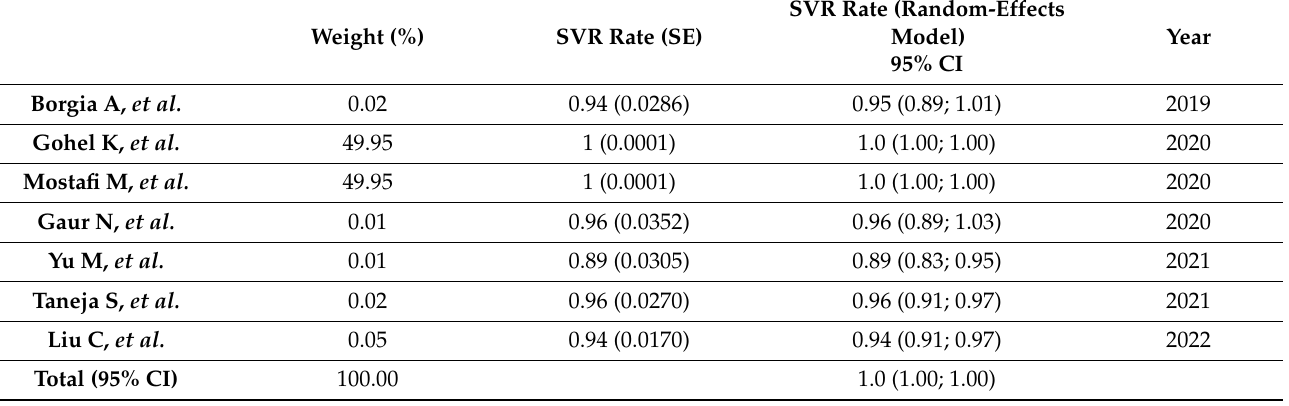
Table 5. Pooled SVR rate after antiviral therapy with pan-genotypic DAAs (SOF/VEL) in